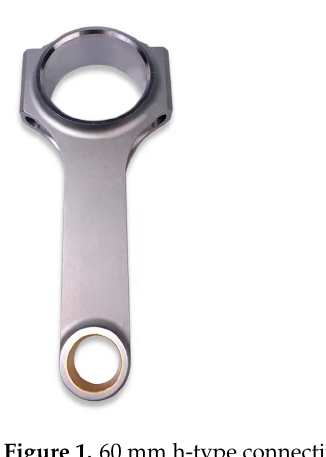
Figure 1. 60 mm h-type connecting rod for Volvo b200/b230 engine.